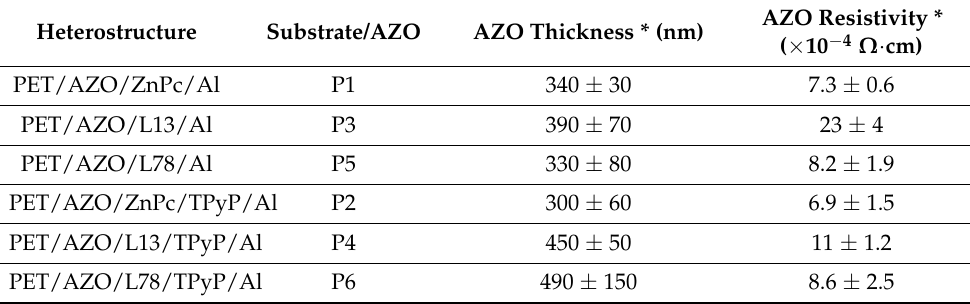
Table 1. Investigated heterostructures and the main properties of the AZO layers.